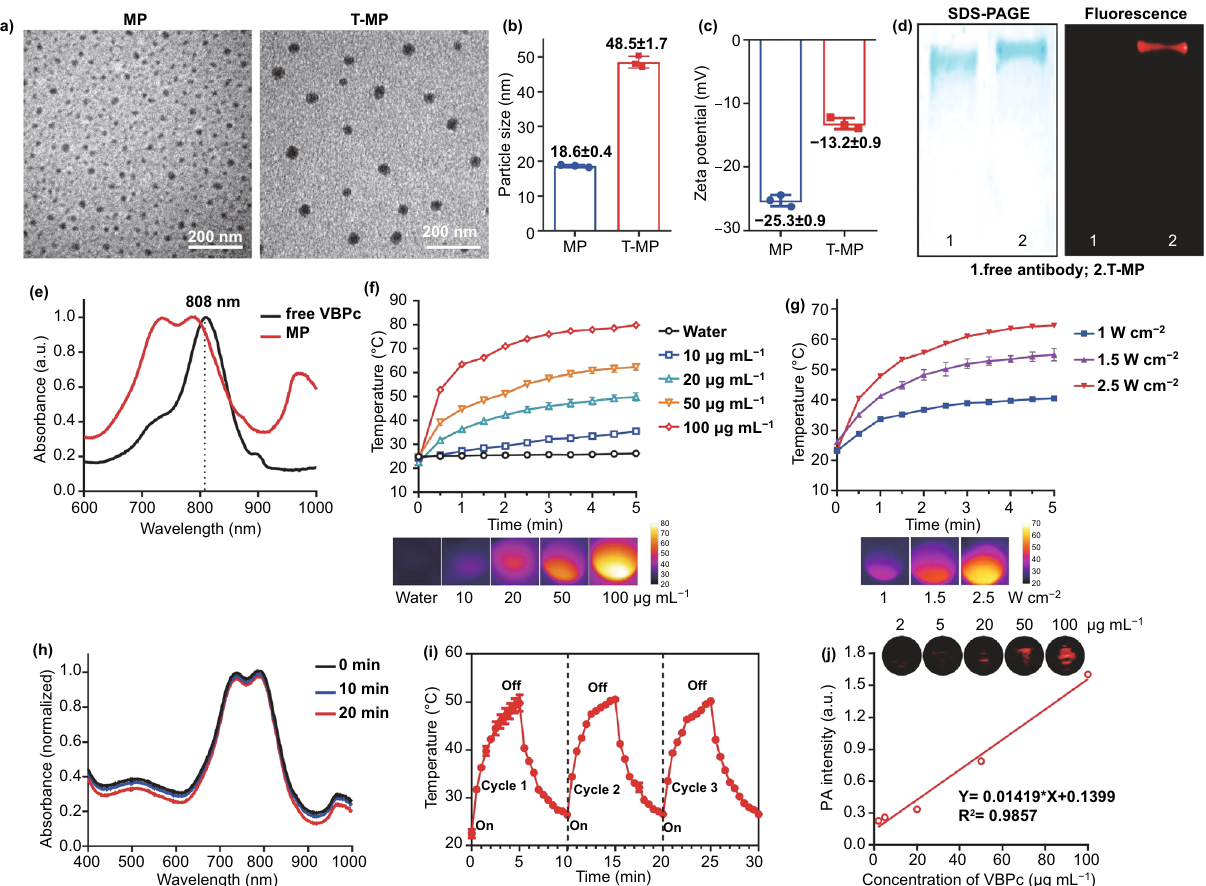
Fig. 1 Characterization of micellular VBPc. a TEM images of MP (unmodified) and T‑MP. Particle size ( b ) and zeta potential ( c ) determined by dynamic light scattering (DLS). d SDS‑PAGE with coomassie blue staining (left) and near‑infrared fluorescence imaging (right) of free anti‑ body and T‑MP. e Vis–NIR absorbance of free VBPc in dichloromethane and unmodified MP in water. f VBPc concentration‑dependent temper‑ ature increases of T‑MP at power density of 2 W cm −2 . Representative photothermal images at 5 min were captured by thermal imaging camera (Testo 890) g Light power‑dependent temperature increase curves of T‑MP (20 μg mL −1 VBPc). Representative photothermal images at 5 min were shown. h Consecutive cycles of laser‑induced heating of T‑MP (VBPc 20 μg mL −1 ) under 808 nm irradiation at 2 W cm −2 . i Influence of irradiation time on the Vis–NIR absorption curve of T‑MP. j PA imaging property of T‑MP. Data are presented as mean ± s.d. ( n =